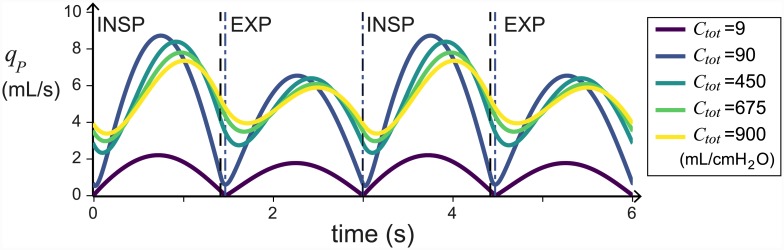
The shape of the flow qP smoothes out as Ctot increases.This figure plots the flow through the parabronchi qP against time for a range of Ctot, with all traces aligned such that the beginning of inspiration is at t = 0. The parameter γ = 1, other parameters are given in Table 1. Note: the transition from inspiration to expiration happens at close to the same time for Ctot ≥ 90 mL/cmH2O and is shown as a black dashed line. The time of the transition for Ctot = 9 mL/cmH2O is shown with a dark blue dot-dashed line.